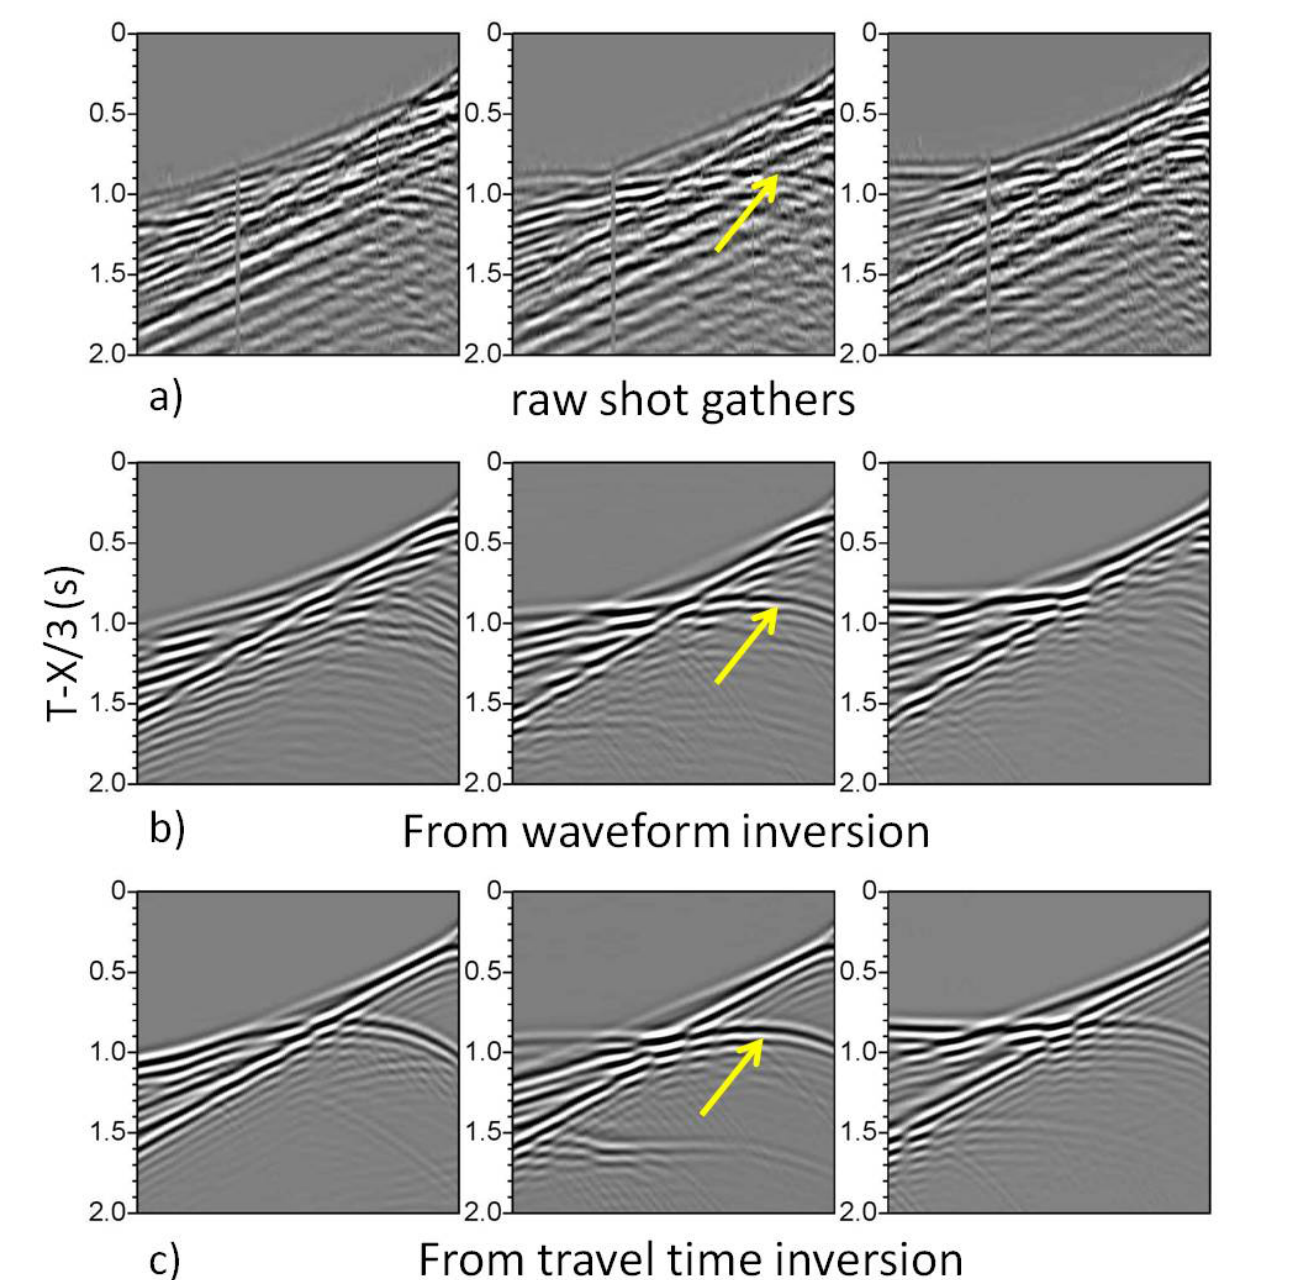
Figure 14. Shot gathers through the high velocity zone at model distance 14 km, 16 km, 18 km. ( a ) Raw shot gathers, ( b ) synthetic shot gathers using FWI velocity model, and ( c ) synthetic shot gathers using travel time velocity model. Arrow indicates a reflector that corresponds to an apparent velocity of > 4